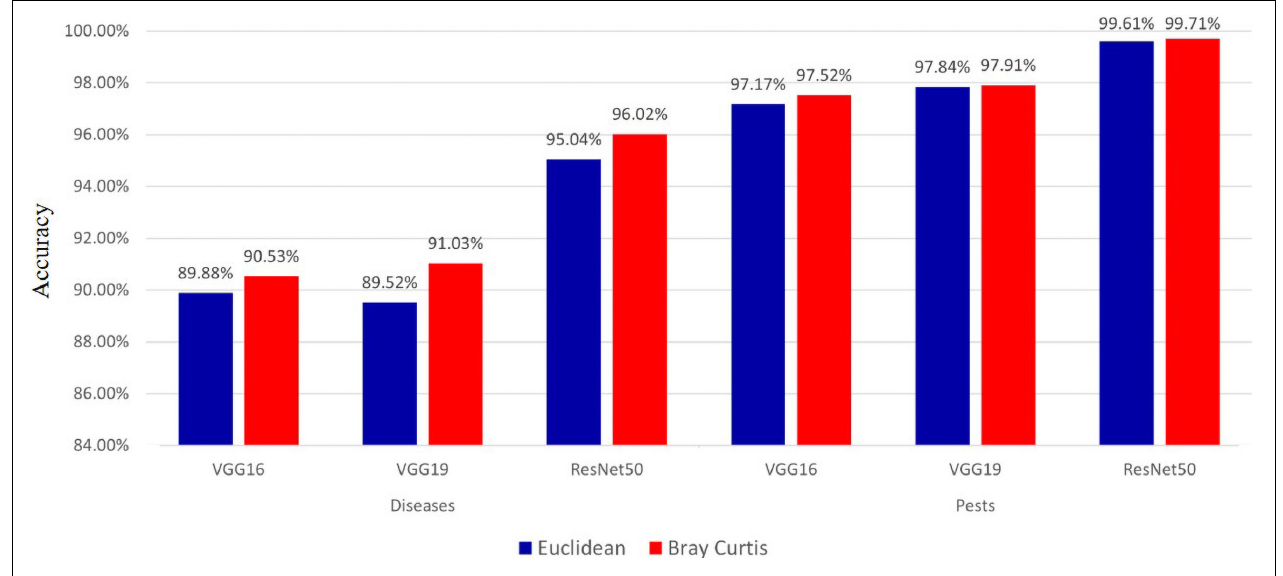
FIGURE 9 | Accuracy comparison of distance metric.